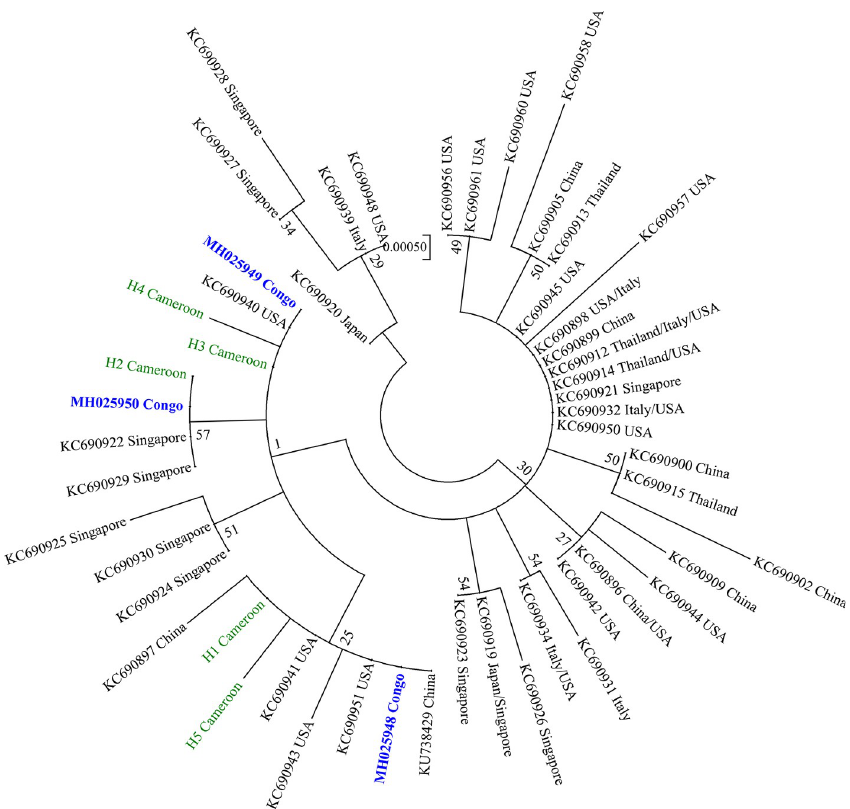
Fig 3. Molecular phylogenetic analysis of Ae . albopictus by maximum likelihood method. The evolutionary history was inferred by using the Maximum Likelihood method based on the Tamura 3-parameter model. The tree is drawn to scale, with branch lengths measured in the number of substitutions per site. There was a total of 636 positions in the final